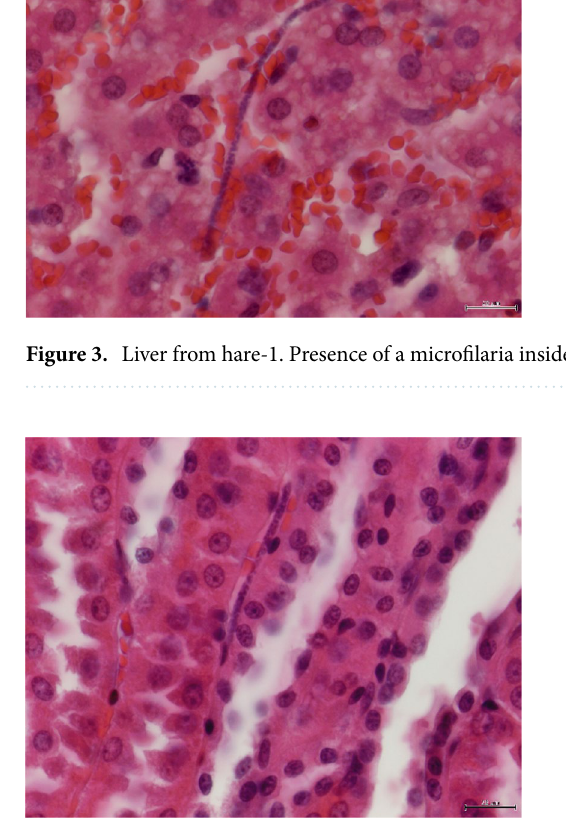
Figure 4. Kidney from hare-1. Presence of a microfilaria in an interstitial tissue vessel. ×400, H&E.